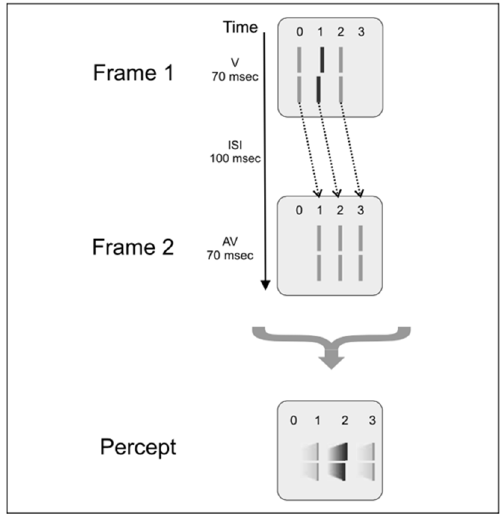
Figure 7. Ternus Pikler Display. Three lines presented, with only the central line being offset. An ISI of 100 ms followed and then another 3 lines were presented, all non-offset and shifted one inter-line spacing to the left. Surprisingly, the first frame offset is not perceived at the left most line in the second frame but at the central line—reflecting that integration respects object identity and occurs not in retinotopic coordinates. Reprinted with permission from ref. [12]. Copyright 2021 MIT